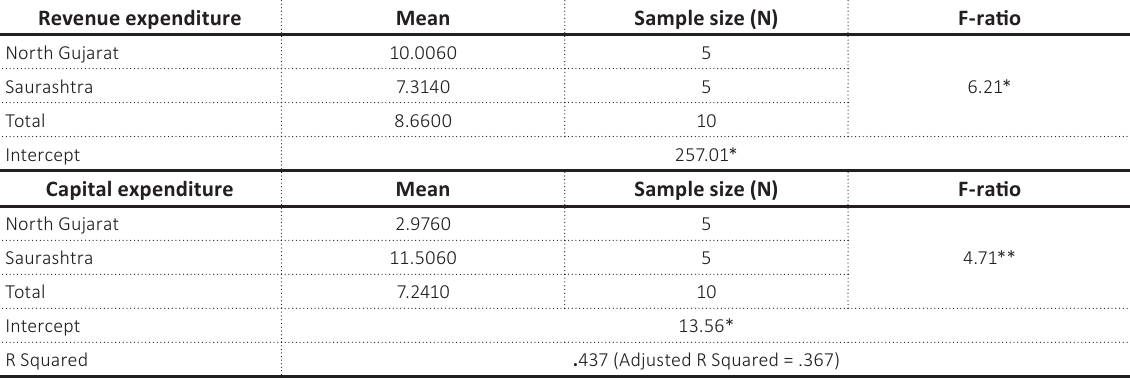
Table 8. Municipalities of North Gujarat and